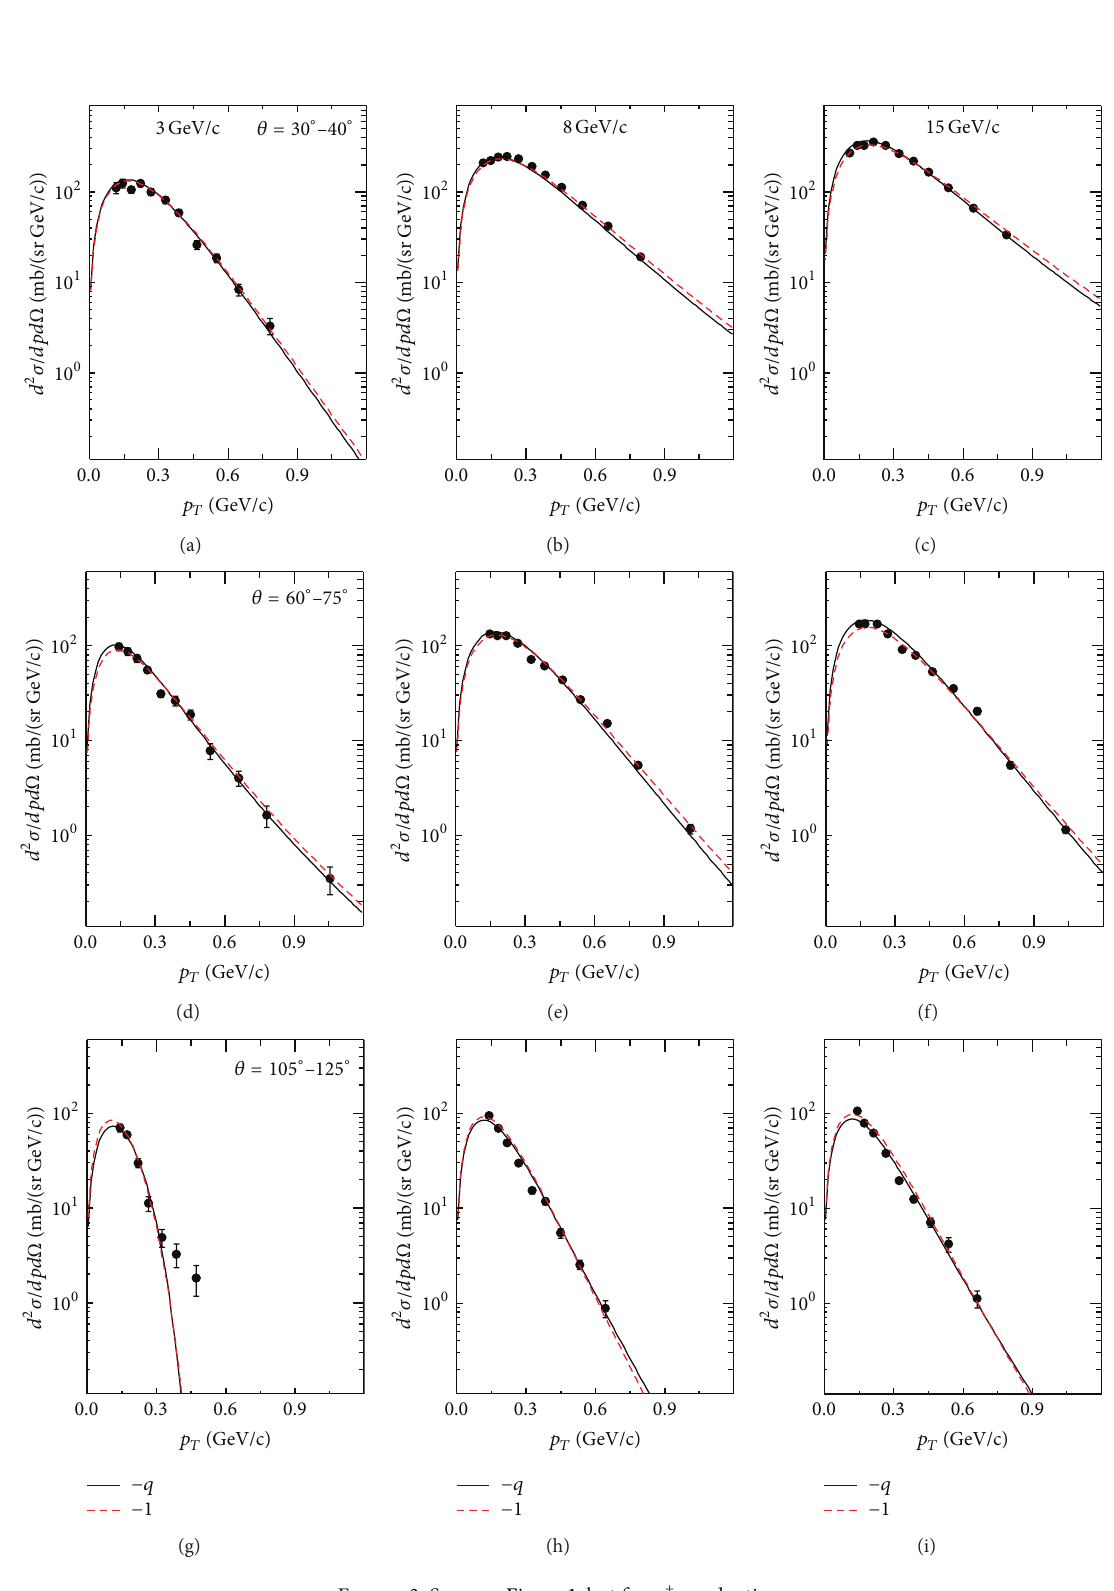
Figure 3: Same as Figure 1, but for 𝜋 +